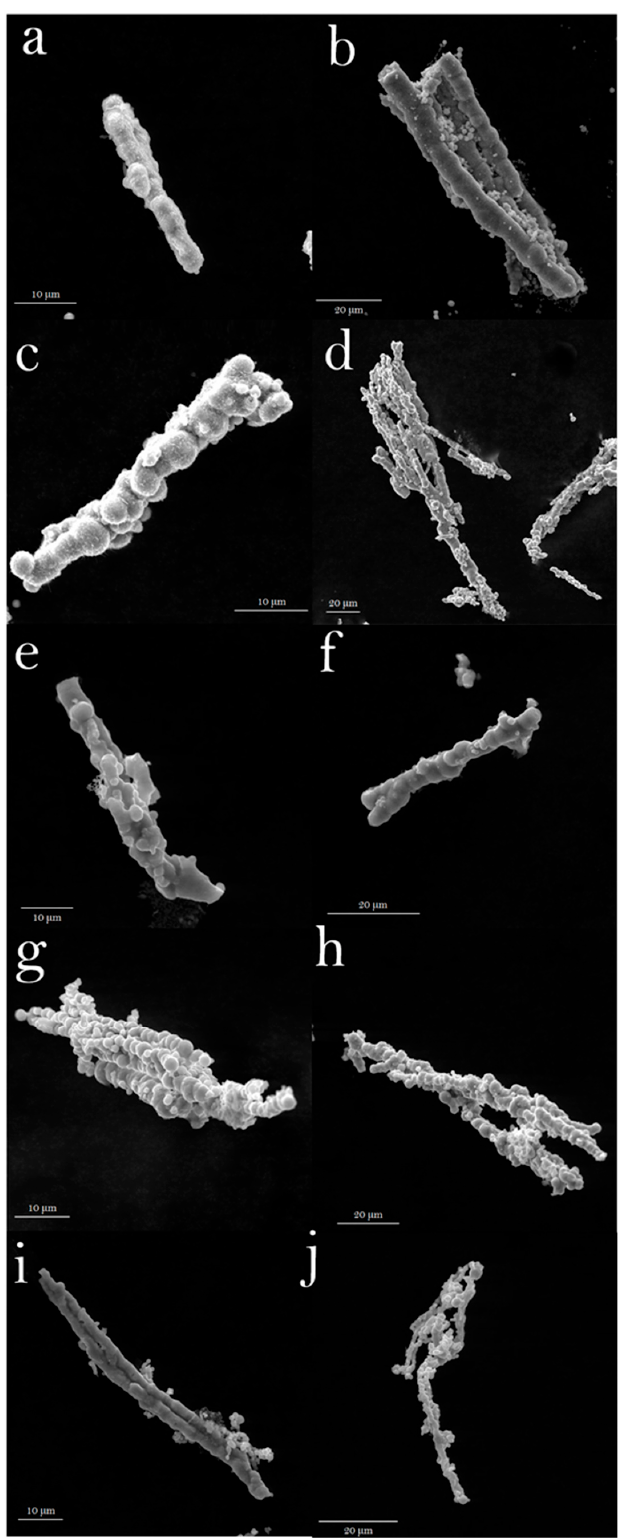
Figure 1. SEM images of samples: After solvothermal reaction ( a , b ), and after calcination: at 300 °C ( c , d ), and at 400 °C ( e , f ), after carbonization: at 600 °C ( g , h ) and at 800 °C ( i , j ).